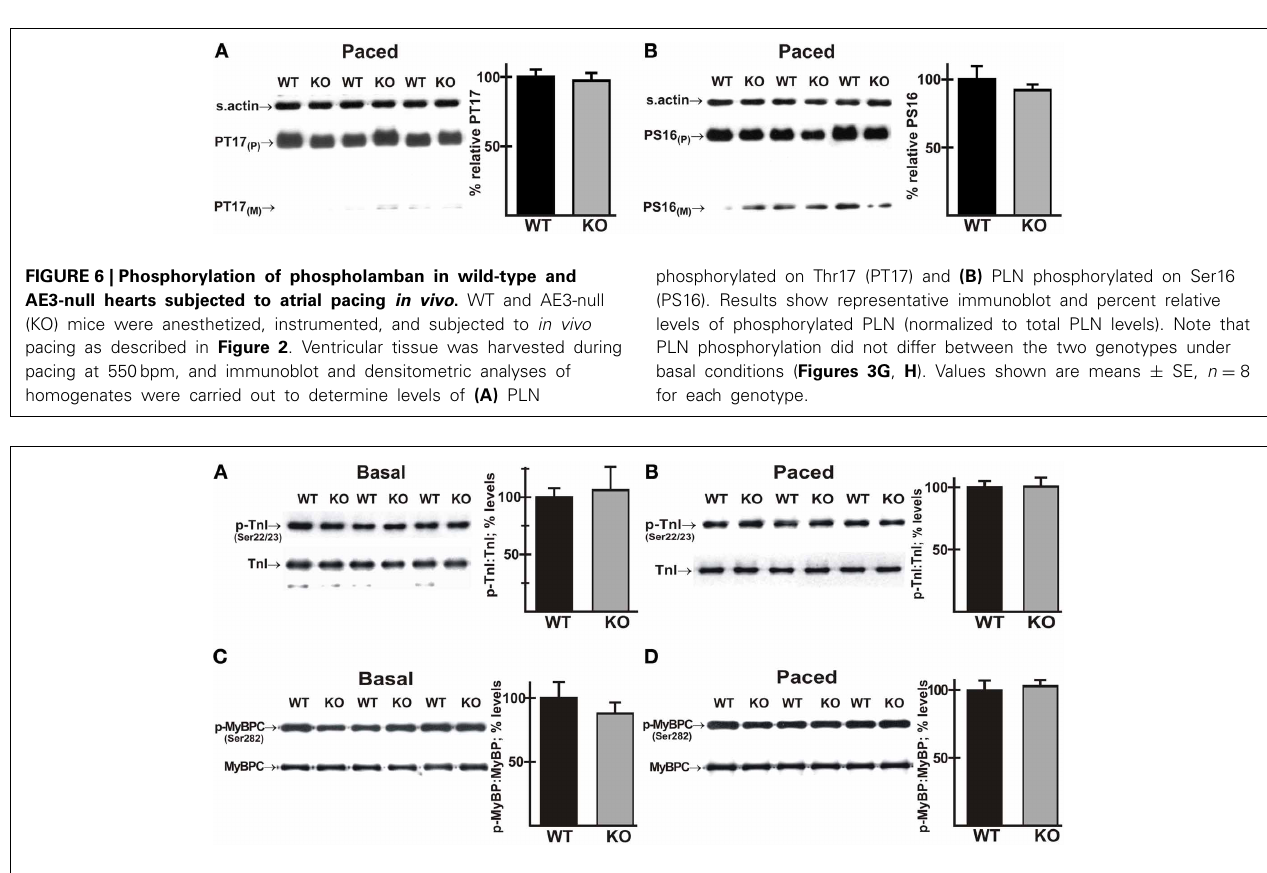
FIGURE 7 | Phosphorylation of cardiac troponin I (TnI) and myosin binding protein-C (MyBP-C) in wild-type and AE3-null hearts subjected to atrial pacing. WT and AE3-null (KO) mice were anesthetized, instrumented, and subjected to pacing as described in Figure 2 . Ventricular tissue was harvested under basal conditions in instrumented controls or during pacing at 550bpm. Immunoblot and densitometric analyses of homogenates were carried out to determine levels of: (A) total TnI and phosphorylated TnI (Ser22/23) under basal conditions; (B) total TnI and